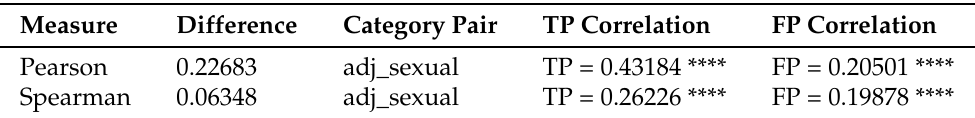
Table 41. Adjectives and Sexual in